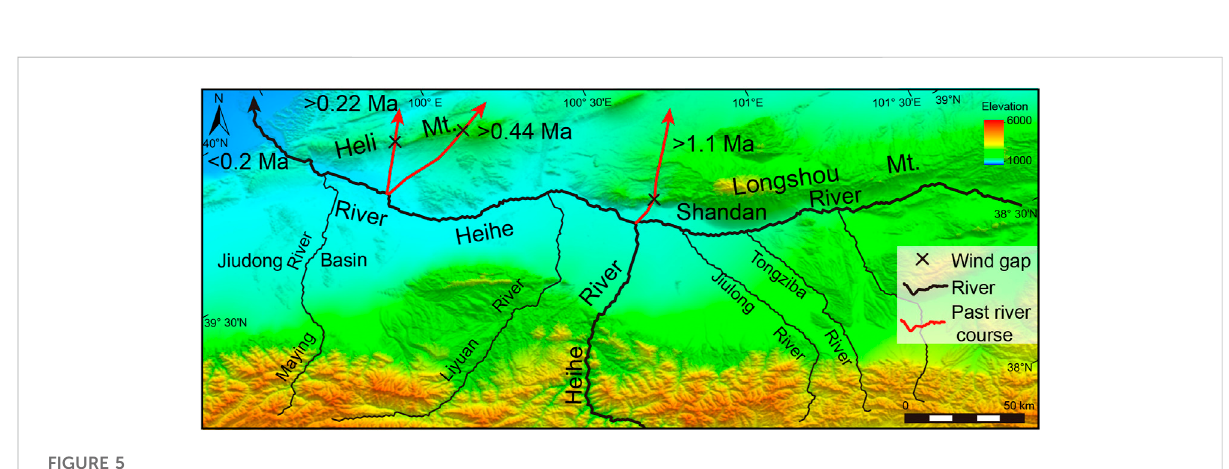
FIGURE 5 Evolution processes of the middle Heihe River in the past 1.1